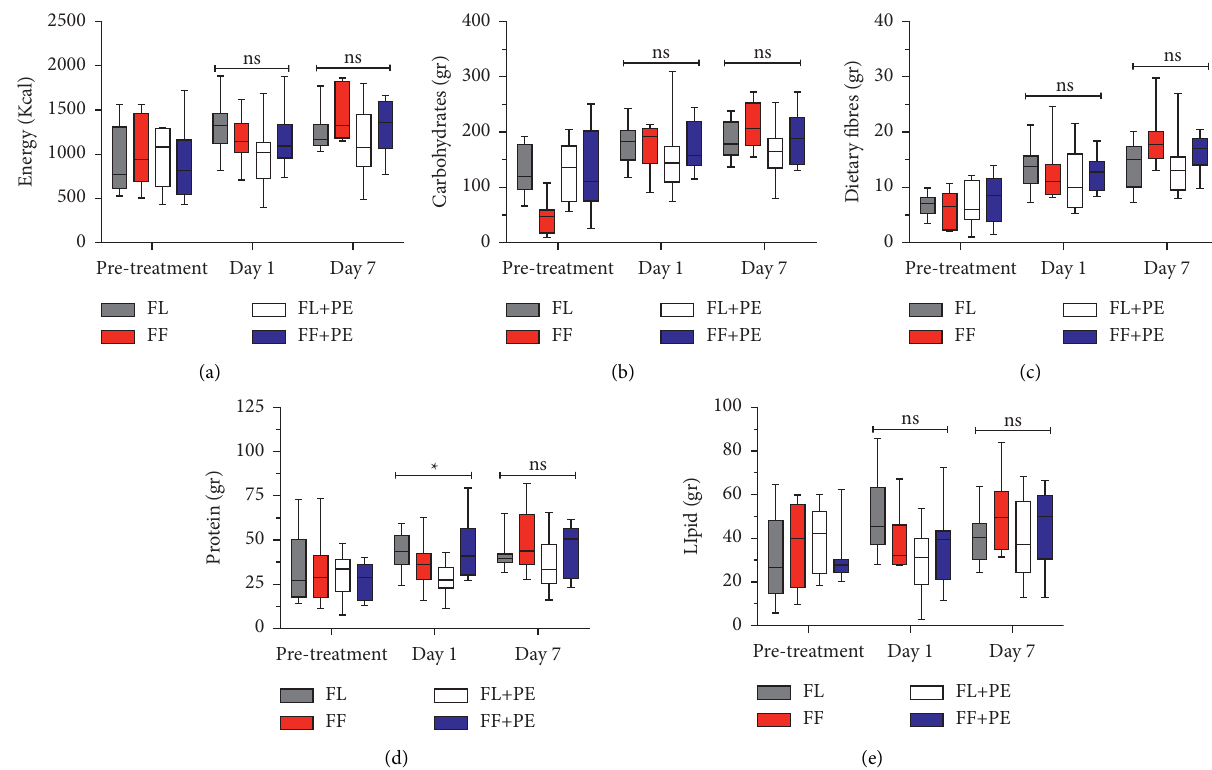
Figure 1: Nutritional intakes on pre-treatment and day 1 and day 7 of a 7-day course of treatment were as follows: (a) energy, (b) carbohydrates, (c) dietary fbre, (d) protein (gr), and (e) lipids (gr). Generally, no signifcant diferences were found in macronutrients consumption on days 1 and 7 except protein consumption on day 1. ns � non-signifcant, ∗ p < 0 .